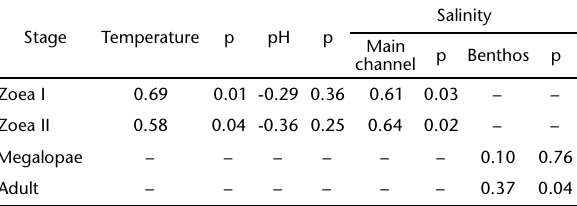
Table II. Spearman coefficients for the correlation between the density of P. armatus (larvae and adults) and abiotic factors. Significant values in bold script (p <